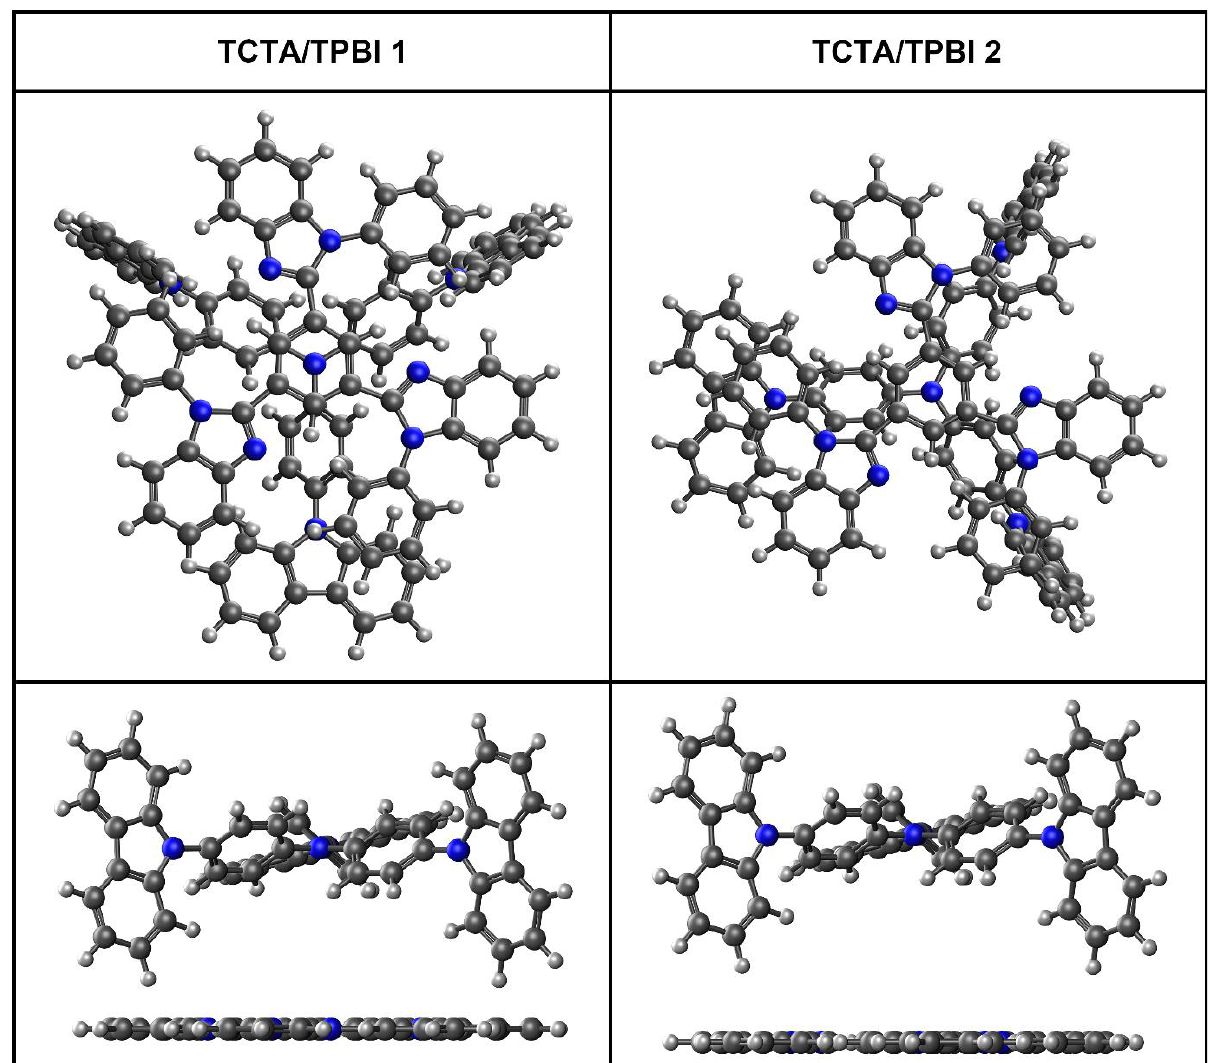
Figure 2. Illustrations of two different face-on TCTA/TPBI complexes. To access the relative stabilities of the two potential configurations of the TCTA/TPBI complex, we obtained one-dimensional ground state potential energy surfaces (PESs) of the complex by scanning the center-to-center distance between the two moieties. We adopted the frozen-monomer approximation and did not allow relaxations of the monomers from their optimized B3LYP geometries [60]. The results are shown in Figure 3, and the binding energies of 1 and 2 obtained in this figure are 0.42 eV and 0.38 eV, respectively. While lifting the frozen-monomer approximation will surely further strengthen these binding energies, the relative difference between the two numbers will likely be similar. Because the difference (0.04 eV) is quite close to the thermal energy, both configurations and other similarly shaped complexes will form readily during the process of generating EML. The equilibrium distances between the two moieties are 6.20 Å for 1 and 7.10 Å for 2 . Thus, TCTA/TPBI 1 is more compact and has a slightly larger binding energy. For simplicity, therefore, when constructing the trimer model systems by further combining Ir(ppy) 3 , we employed 1 and fixed the TCTA-TPBI center-to-center distance at 6.20